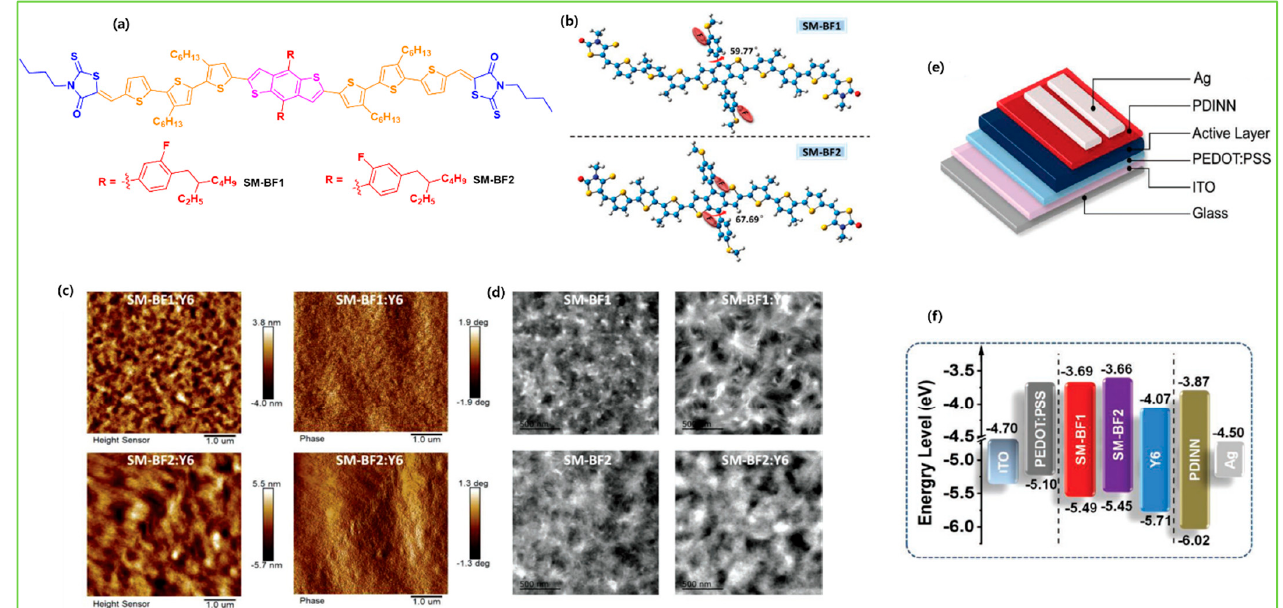
Figure 11. ( a ) Chemical structures of the SMDs SM − BF1 and SM − BF2. ( b ) Optimized molecular structures of the SMDs obtained from the DFT-based theoretical calculations. ( c ) AFM height images and phase images of the SM-BF1:Y6 and SM − BF2:Y6-blend films. ( d ) TEM images of the SM − BF1 and SM − BF2 neat films and the SM − BF1:Y6 and SM − BF2:Y6 blend films. ( e ) Device structure and ( f ) energy level diagram of the related materials used in the SM-OSCs. Adapted with permission from [14]. Copyright 2021, John Wiley and Sons.